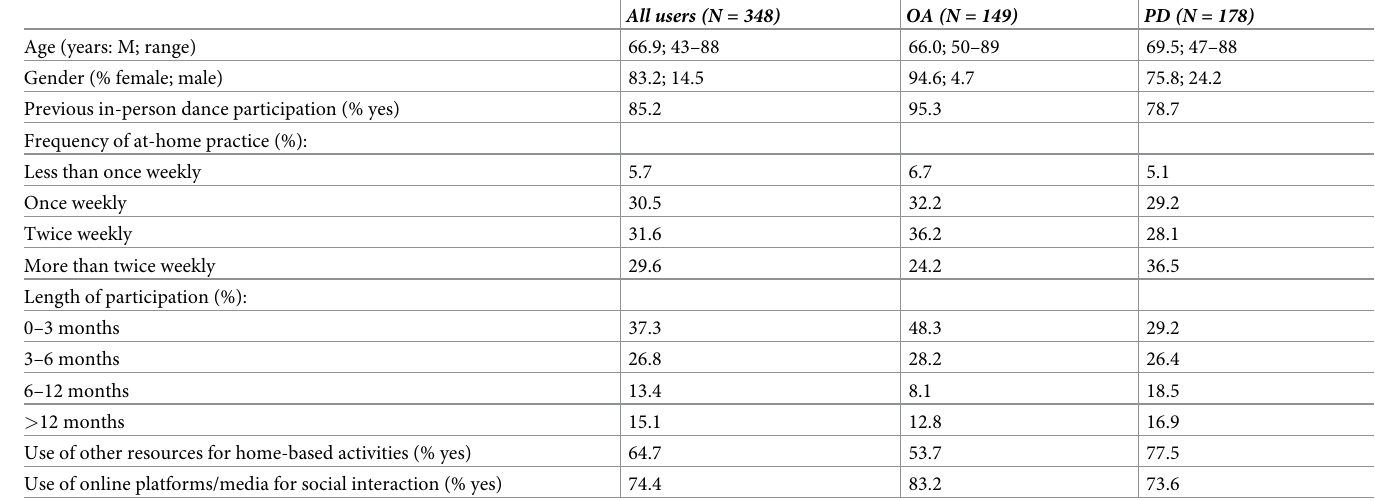
Table 1. Characteristics of participants currently using home-based resources, summarised for all users of at-home dance programs (including those with and with- out any neurological conditions) and separately for older adults without a neurological condition (OA) and individuals with Parkinson’s disease (PD). All users (N =